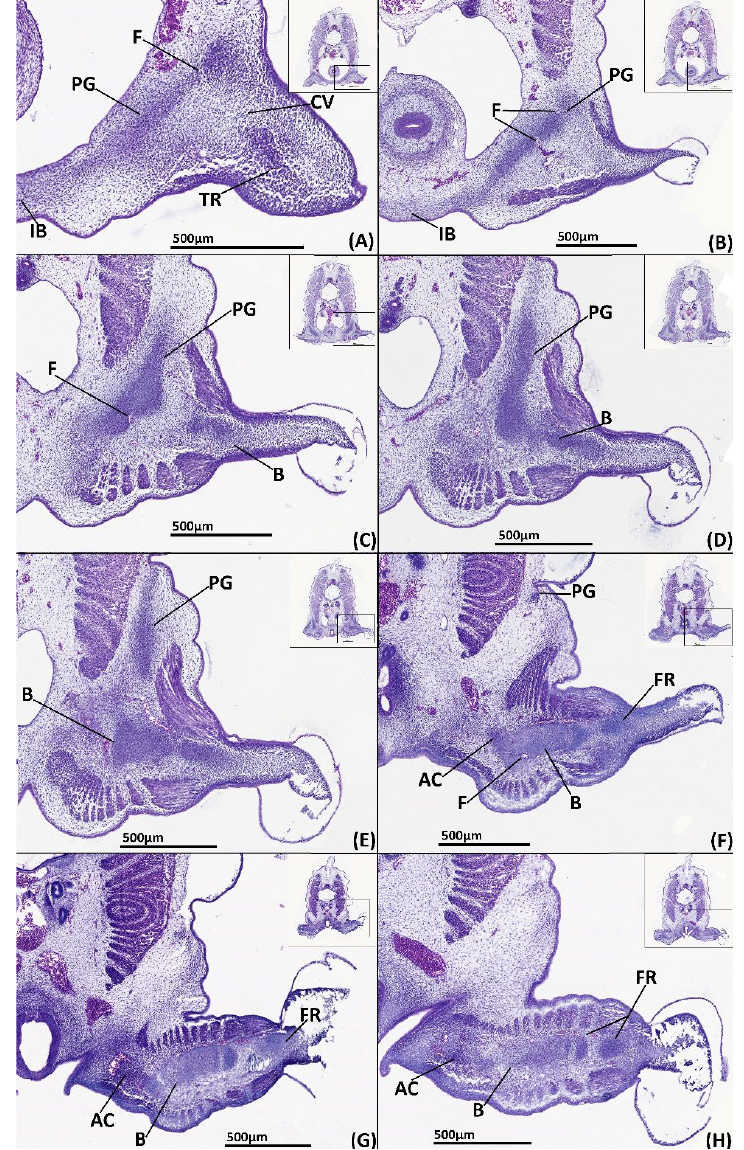
Figure 5. Close ups of transverse paraffin sections of a male stage 31 elephant shark ( Callorhinchus milii ) embryo stained with haematoxylin, eosin and alcian blue, presented in an anteroposterior order. The position of each close up is indicated by black boxes in the inset images. ( A ) close up of trunk section showing the anterior process of the mesenchymal pelvic girdle, the central vacuity and the tenacula rudiments; ( B ) close up of trunk section showing the posterior region of the anterior process and the first foramina anterior of the iliac process; ( C ) close up of trunk section showing the beginning of the mesenchymal iliac process and anterior region of basipterygium; ( D ) close up of trunk section showing the connection mesenchymal pelvic girdle and basipterygium; ( E ) close up of trunk section showing the mesenchymal basipterygium and dorsal regions of the mesenchymal iliac process; ( F ) close up of trunk section showing the connection of the mesenchymal basipterygium with a fin radial and the mesenchymal anterior clasper cartilage; ( G ) close up of trunk section showing the connection of the mesenchymal basipterygium and anterior clasper cartilage; ( H ) close up of trunk section showing the connection between the posterior regions of the basipterygium and the anterior clasper cartilage.AC-anterior clasper cartilage B-basipterygium CV-central vacuity F-foramina FR-fin radial IB-inter-pelvic band PC-posterior clasper cartilage PG-pelvic girdle. Anatomical orientation of models indicated by A-anterior D-dorsal P-posterior R-right L-left